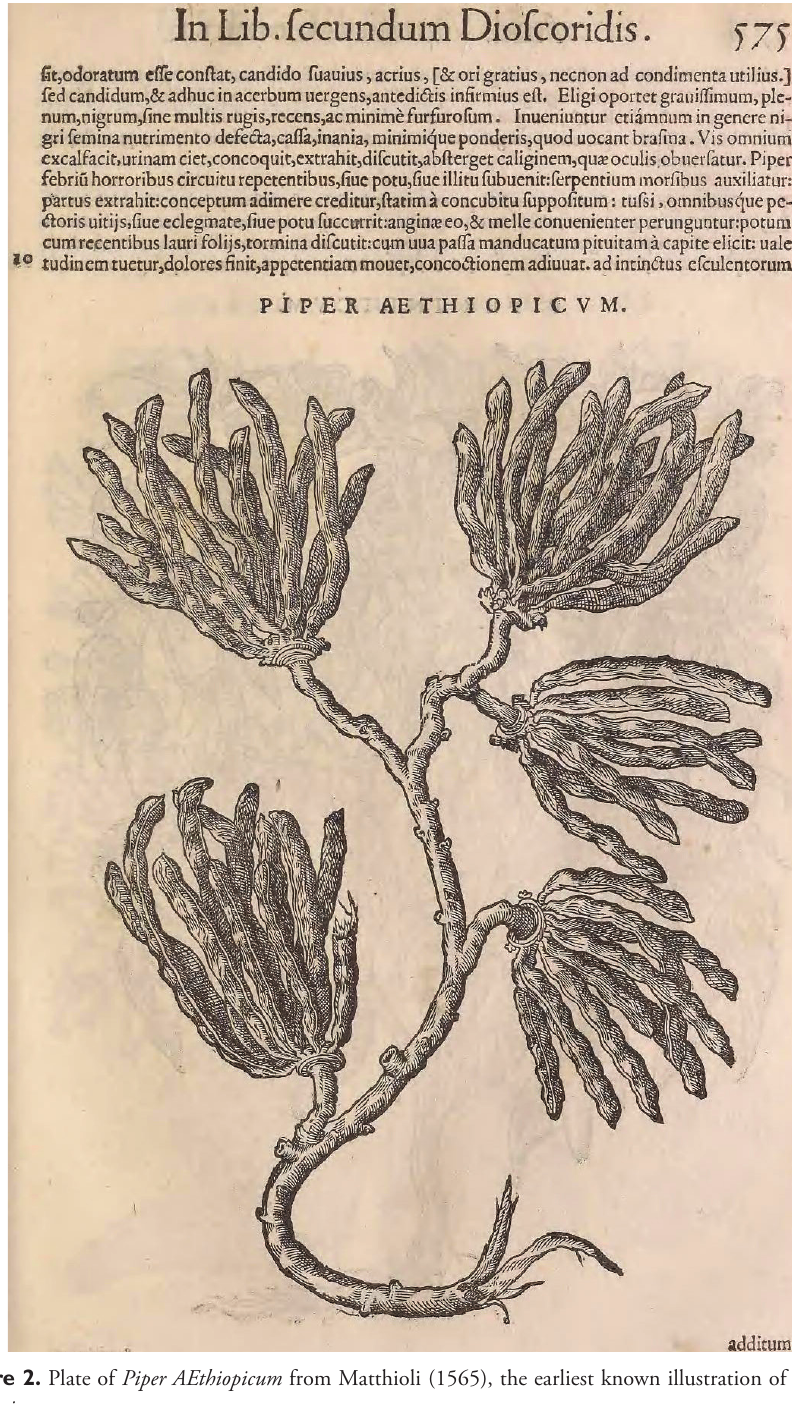
Figure 2. Plate of Piper AEthiopicum from Matthioli (1565), the earliest known illustration of Xylopia aethiopica